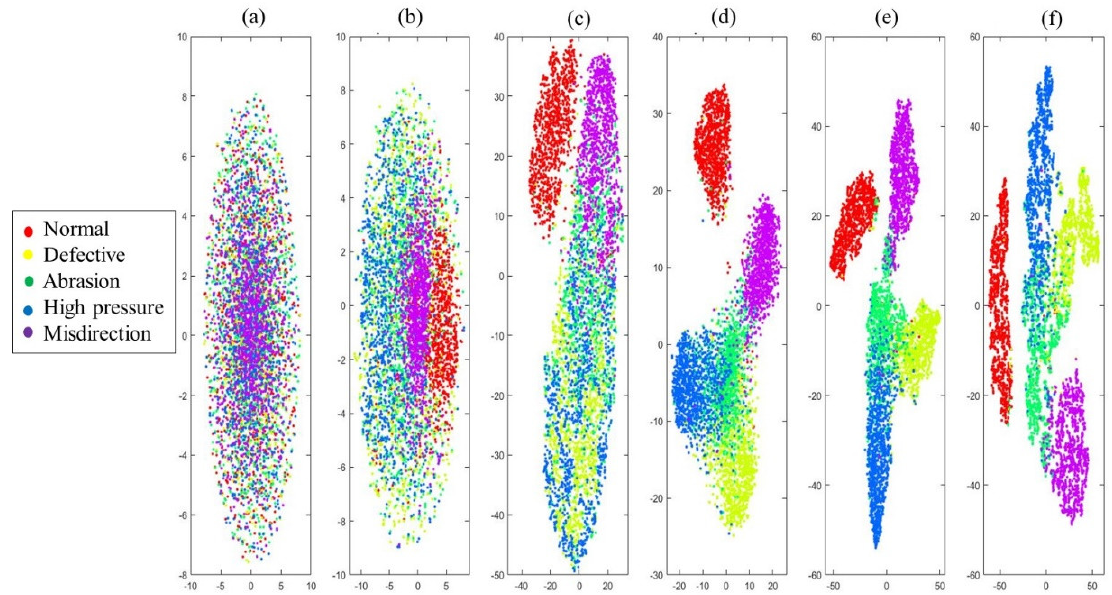
Figure 8. Visualization of the DBFD model’s activations using the t-distributed stochastic neighbor embedding (t-SNE) method. t-SNE was used to visualize clustering as training occurred in ( a ) convolution 1, ( b ) max pooling 1, ( c ) convolution 2, ( d ) max pooling 2, ( e ) fully connected layer 1, and ( f ) the softmax layer of the DBFD 2 model.